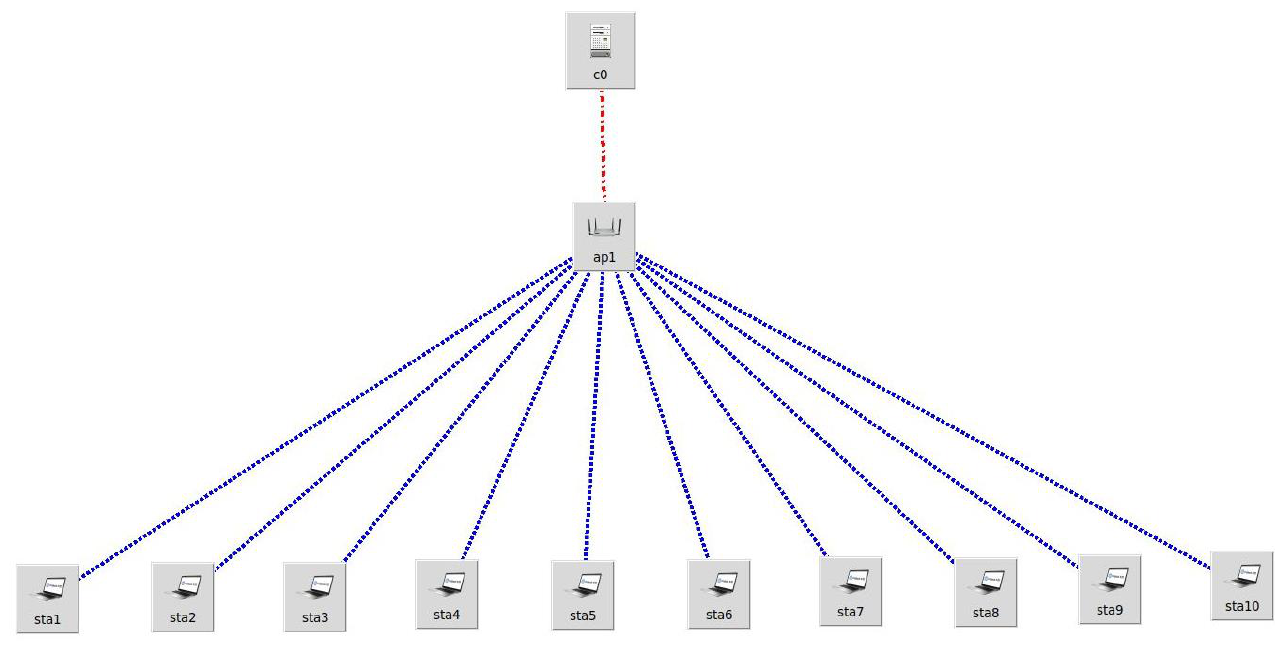
Figure 3. Simple topology.